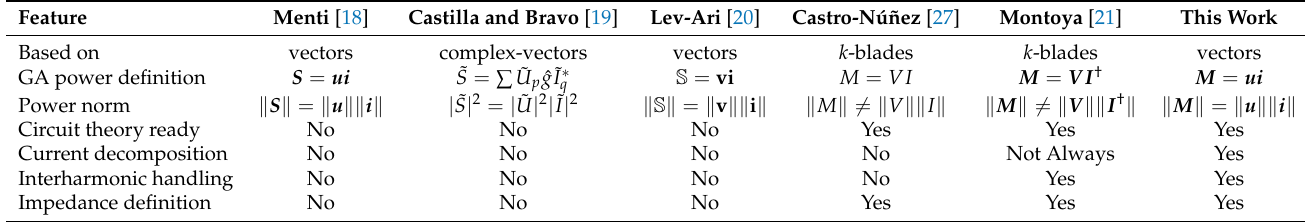
Table 1. Comparison of the main contributions of GA power